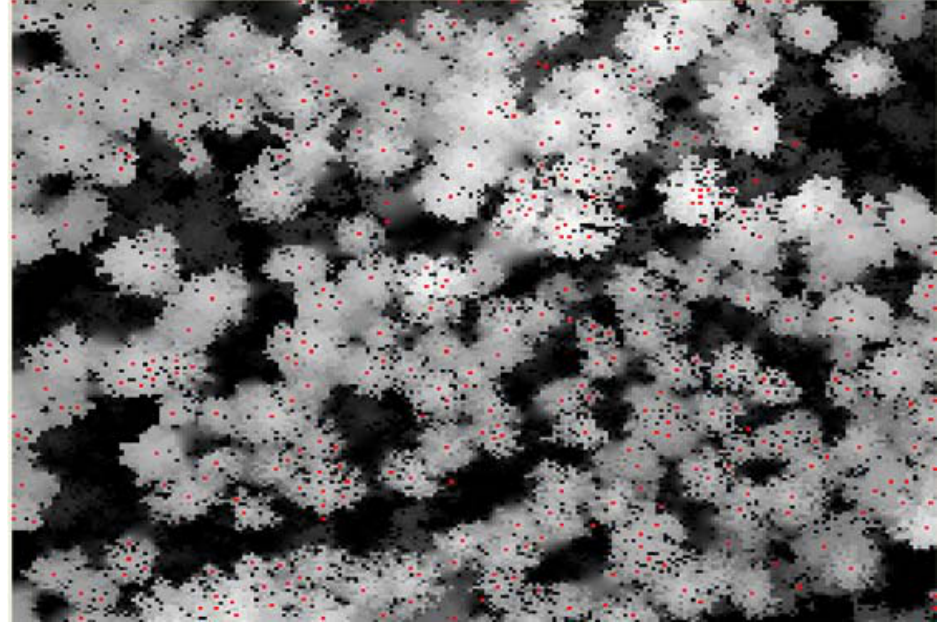
Figure 6. Extracted local maxima overlaid on DSM (red colored